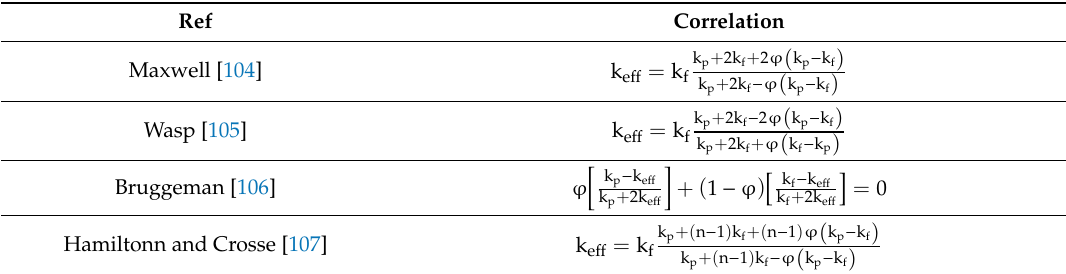
Table 6. The relationships presented on the thermal conductivity for di ff erent